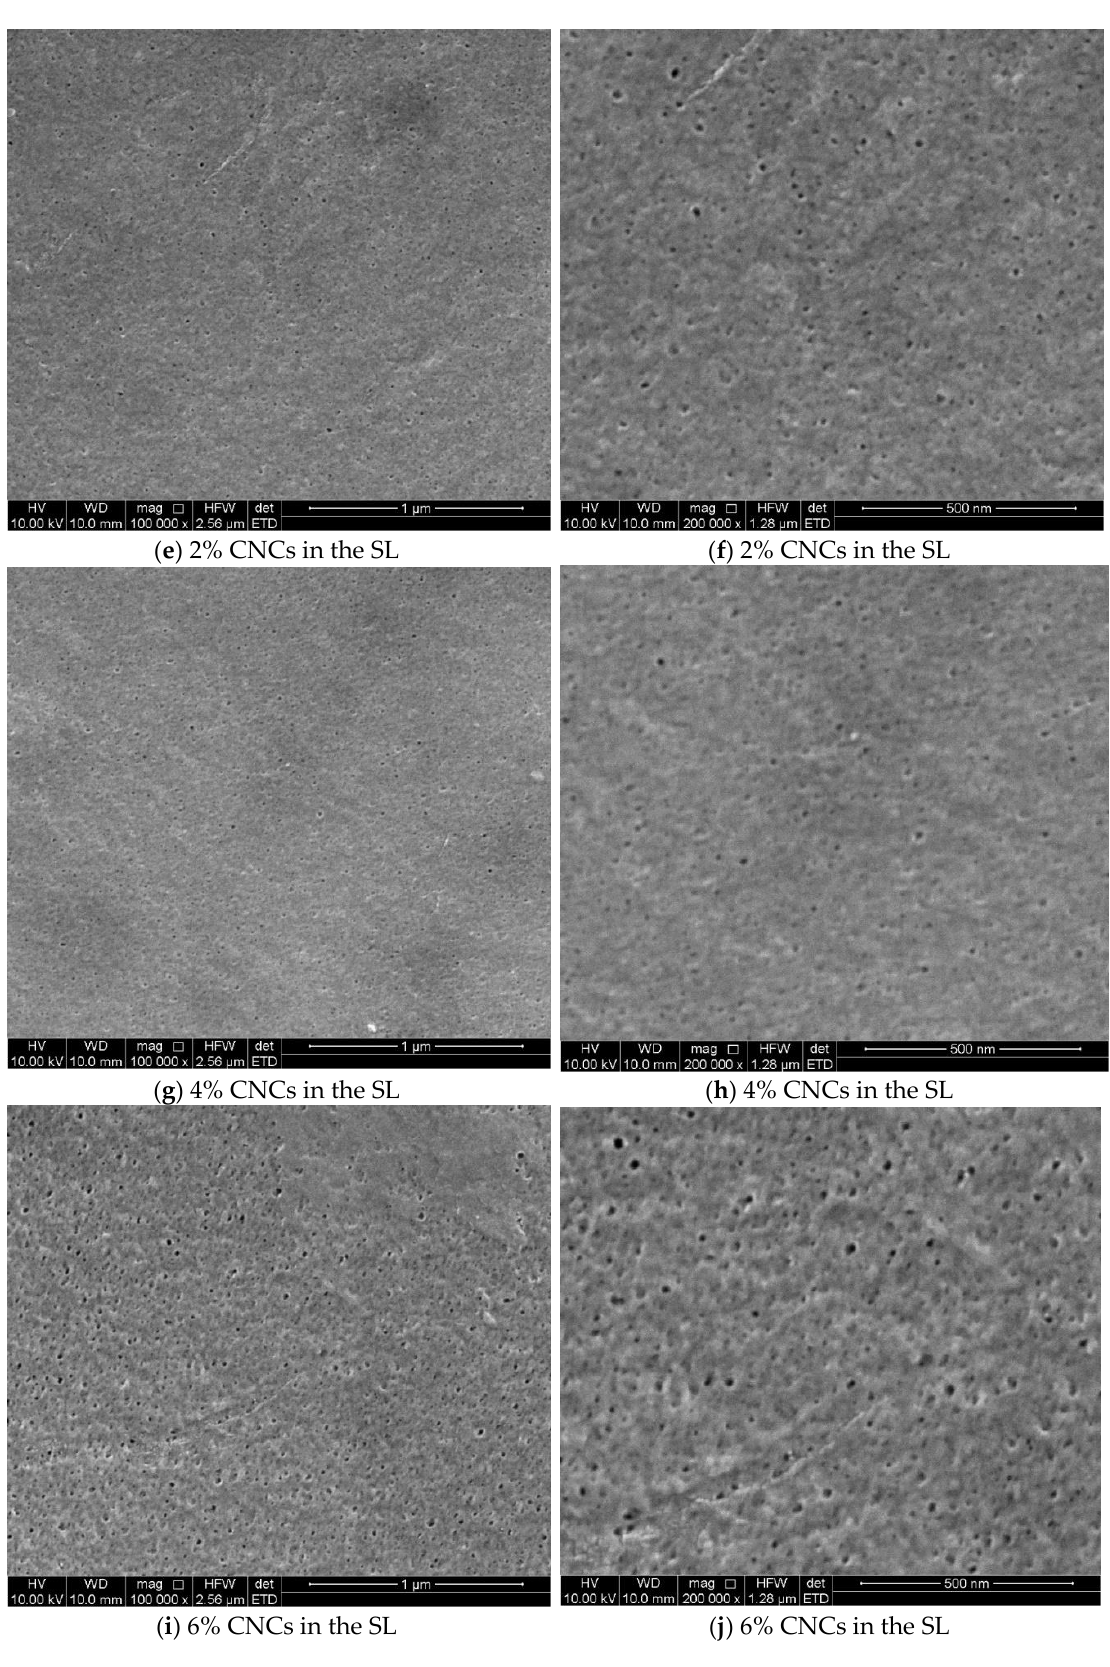
Figure 3. SEM images for the polysulfone support layer filled with different CNCs ratios, ( a , b ) 0%,